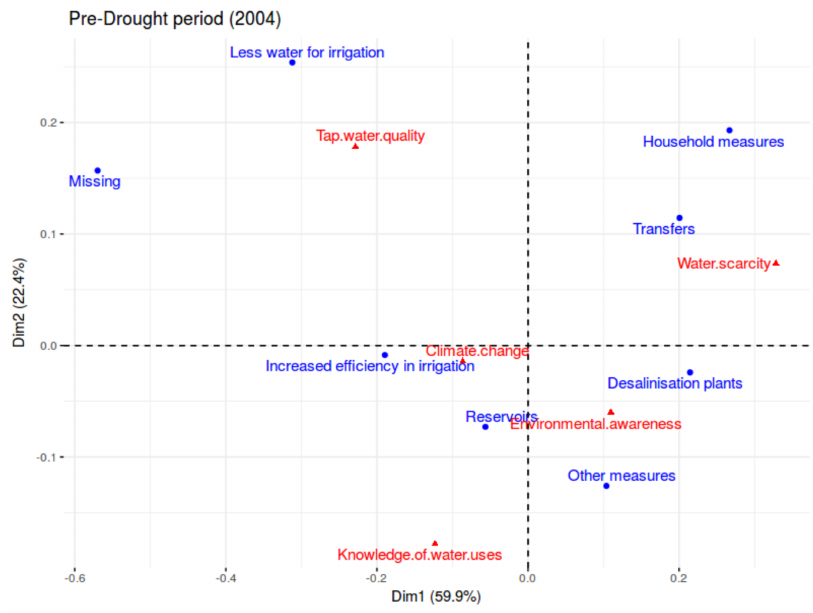
Figure 3. Correspondence analysis: context variables and public preferences concerning water management policies in the pre-drought period (2004). Source: Authors’ own after EBA 2004–2013